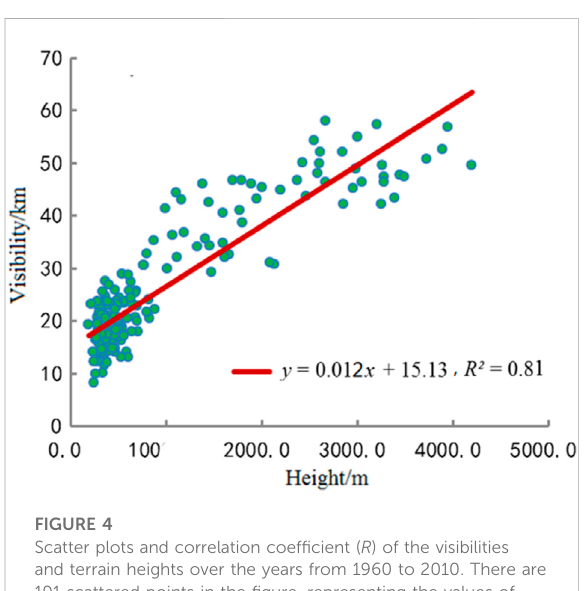
FIGURE 4 Scatter plots and correlation coef fi cient ( R ) of the visibilities and terrain heights over the years from 1960 to 2010. There are 191 scattered points in the fi gure, representing the values of 191 meteorological observation